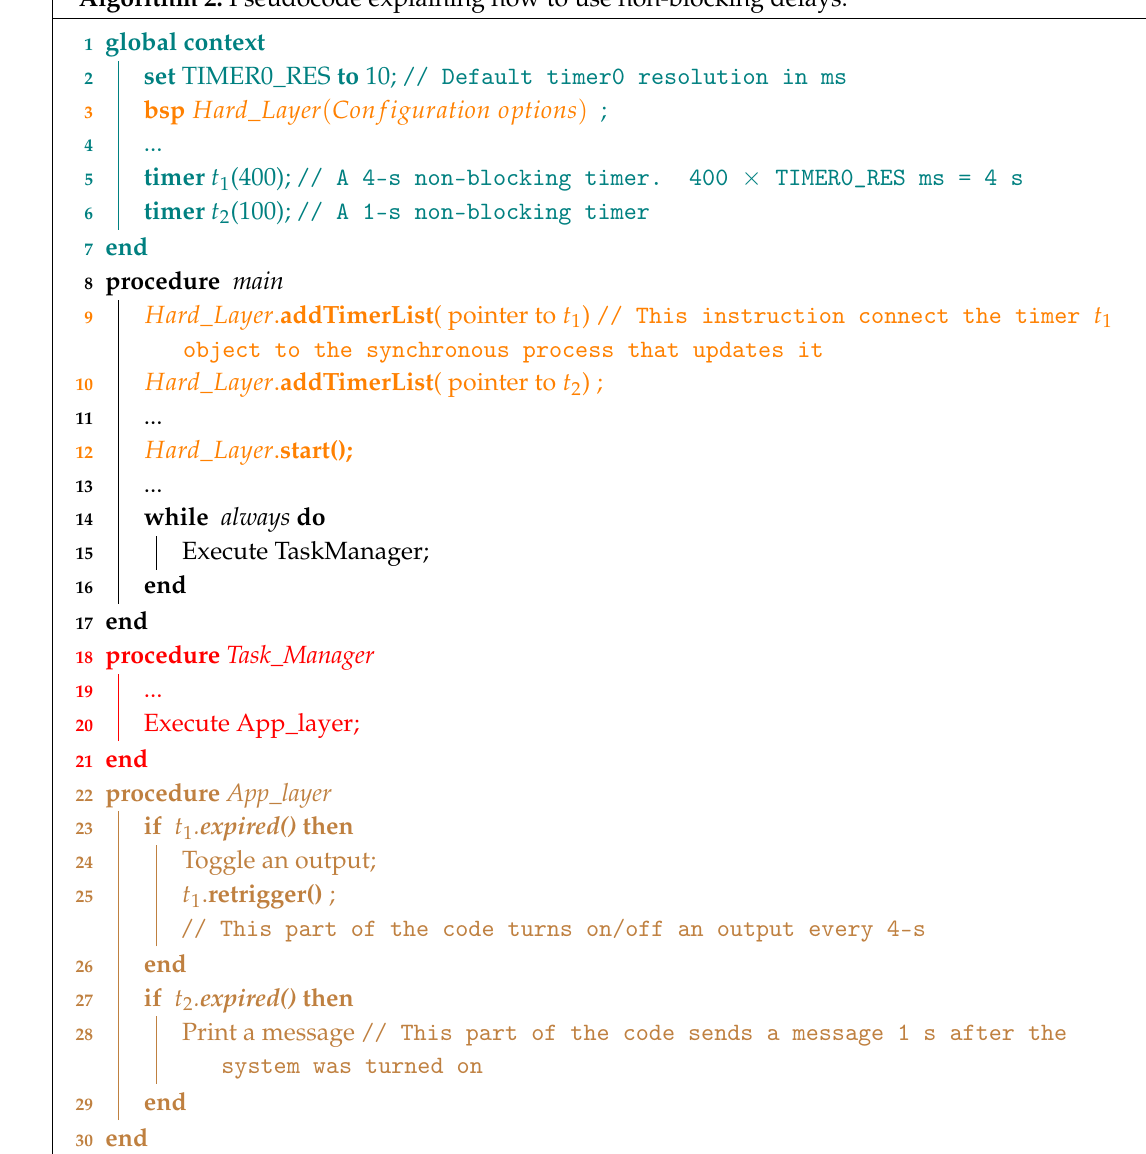
Algorithm 2: Pseudocode explaining how to use non-blocking